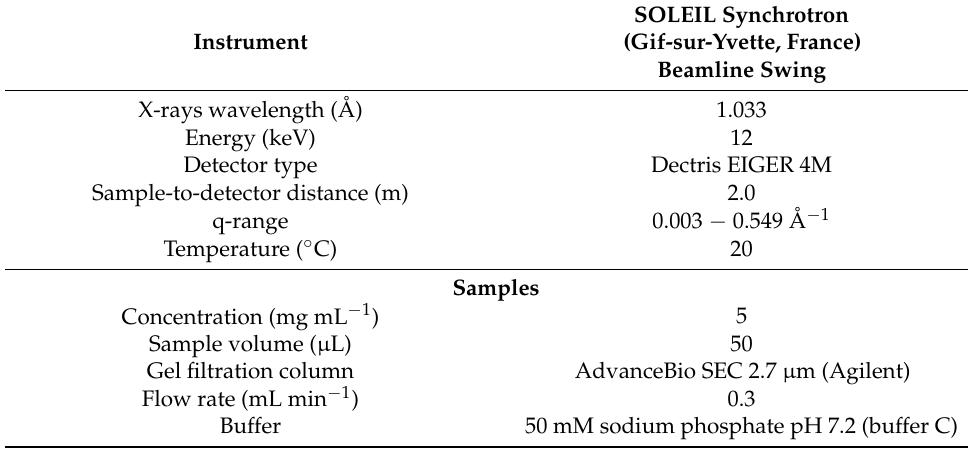
Table 3. SEC-SAXS data acquisition